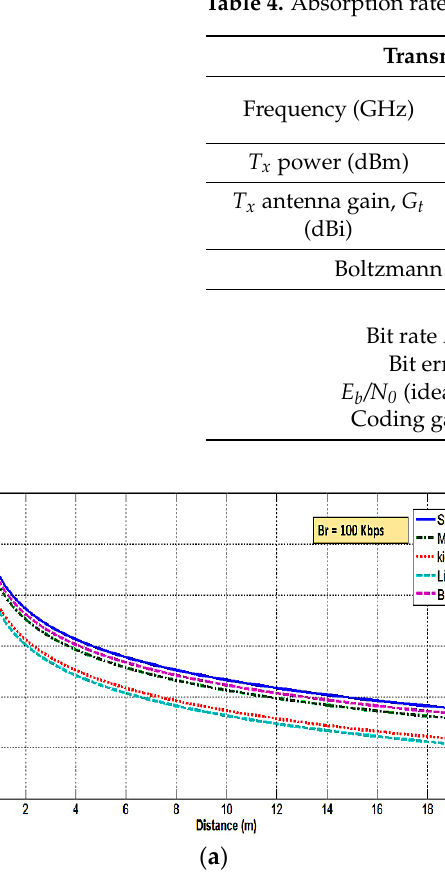
Figure 14. Calculated link margin at bit rate of ( a ) 100 Kbps and ( b ) 1 Mbps for different scenarios.